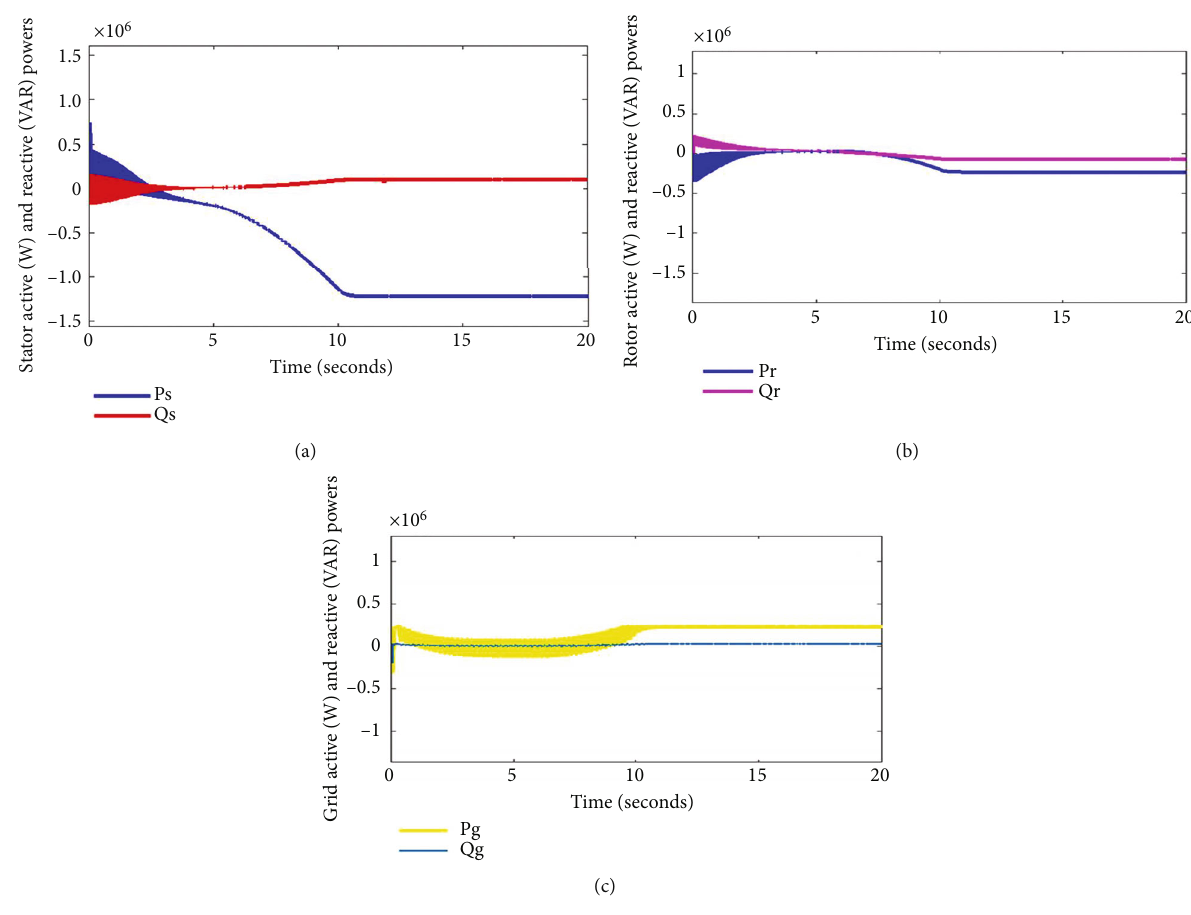
Figure 14: (a – c) Stator, rotor, and grid active and reactive powers using